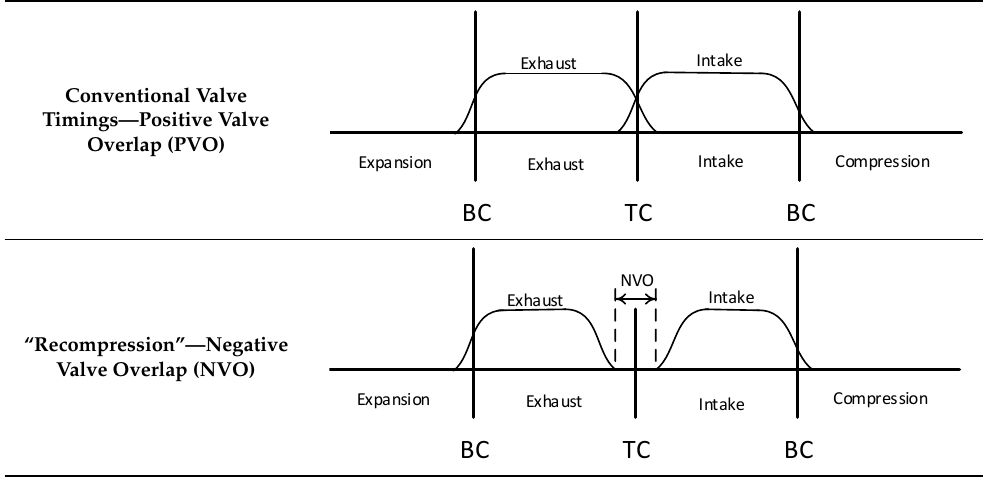
Table 5. Alternative Valve Timings for Internal Exhaust Gas Dilution.